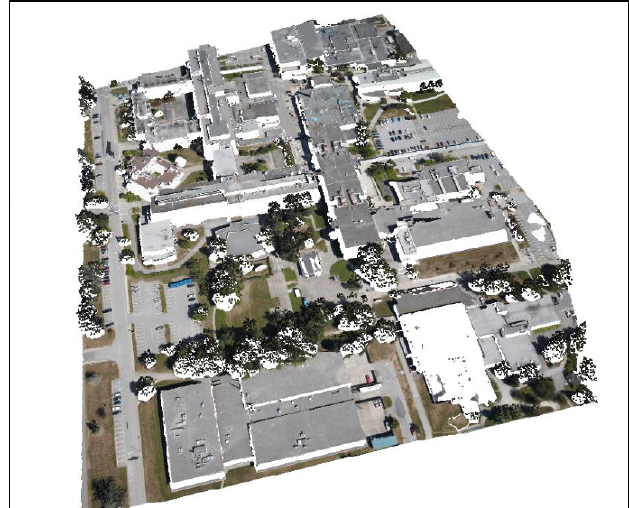
Figure 31. Realistic 3D surface reconstruction outcome for the second dataset: a single view of the textured planar surfaces and individually colored non-segmented points.